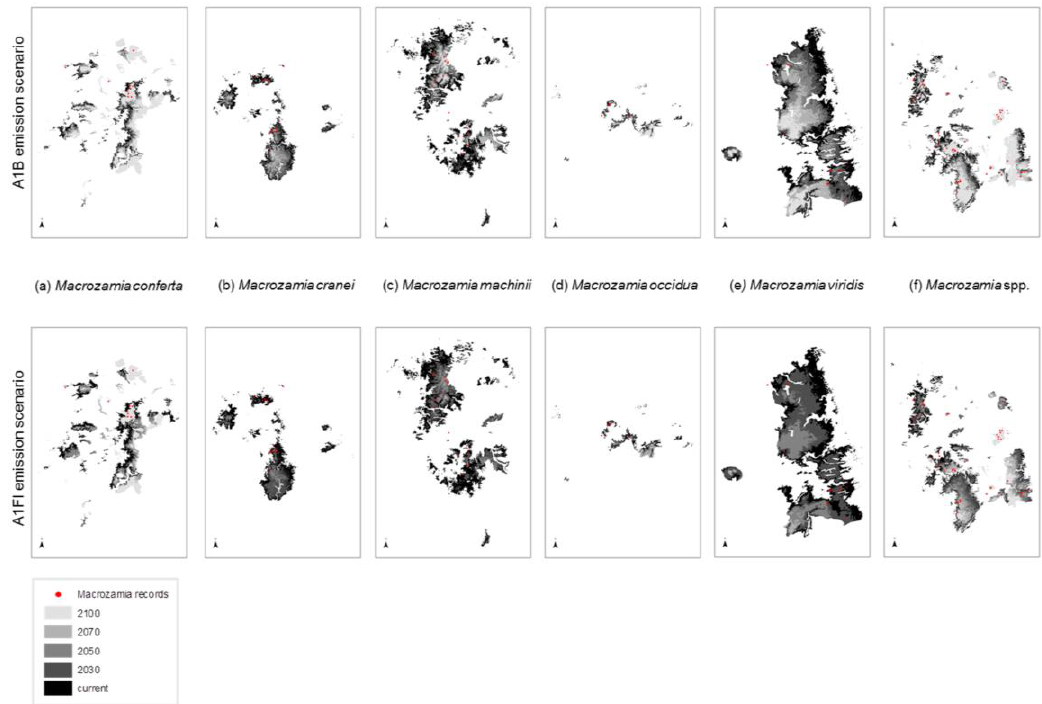
Figure 2. Predicted changes in the range of Darling Downs Macrozamia cycads with increasing annual mean temperature under A1B and A1FI emission scenarios (a) M. conferta